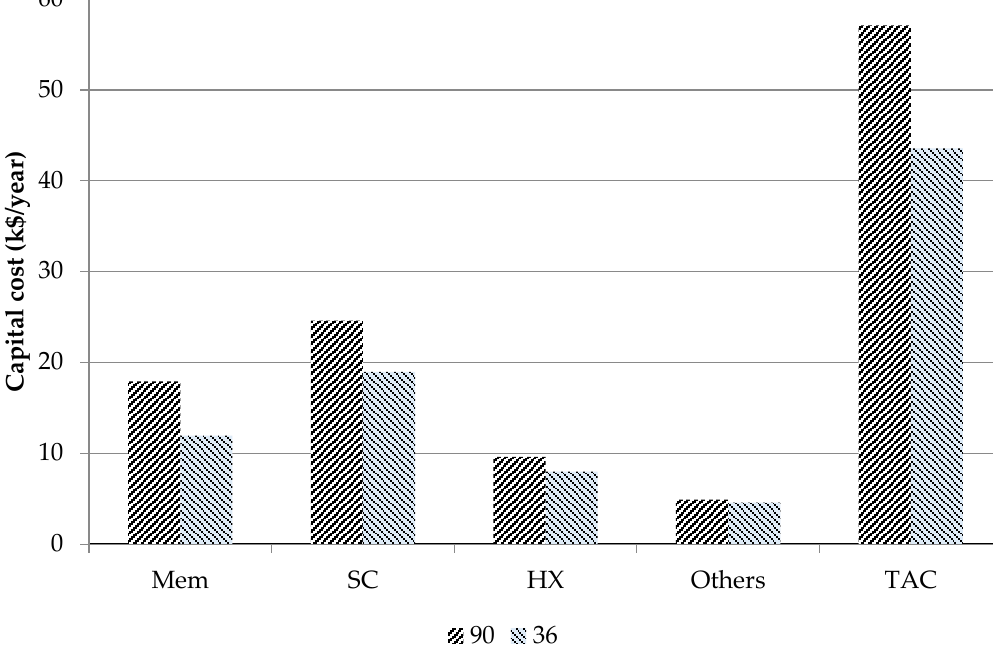
Figure 9. Equipment costs of the optimal solar-driven AGMD system for desalination with different membrane costs ($90/m 2 and $36/m 2 ).